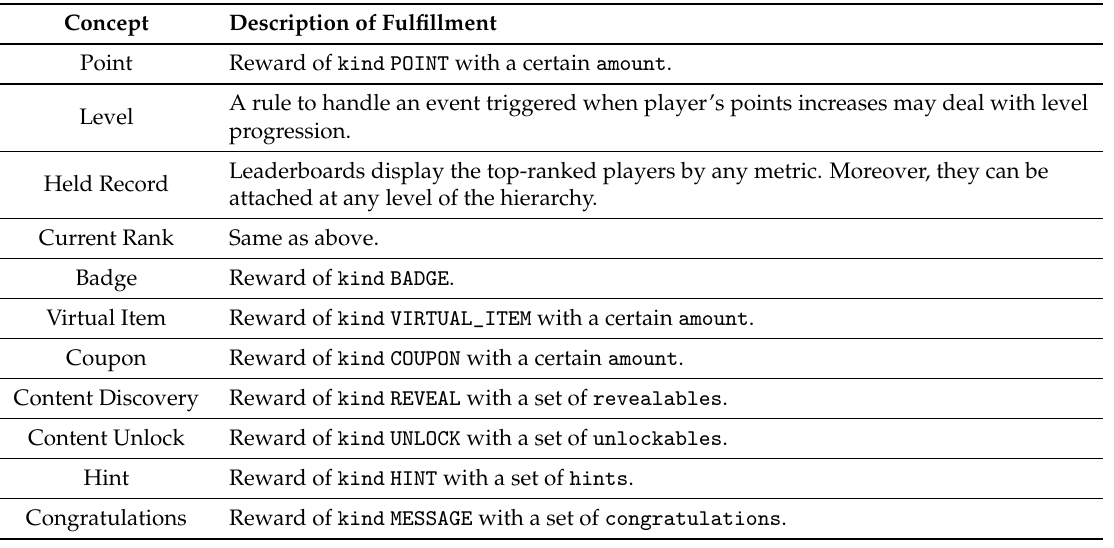
Table 3. Fulfillment of requirements from gamification concepts related to definition of